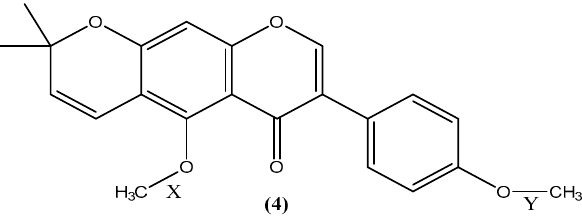
Figure 2. Structure of O , O -dimethylalpinumisoflavone ( 4 ) and the two carbon-oxygen bonds under investigation X and Y. Table 1. Bond dissociation energies (BDEs) in kcal/mol.